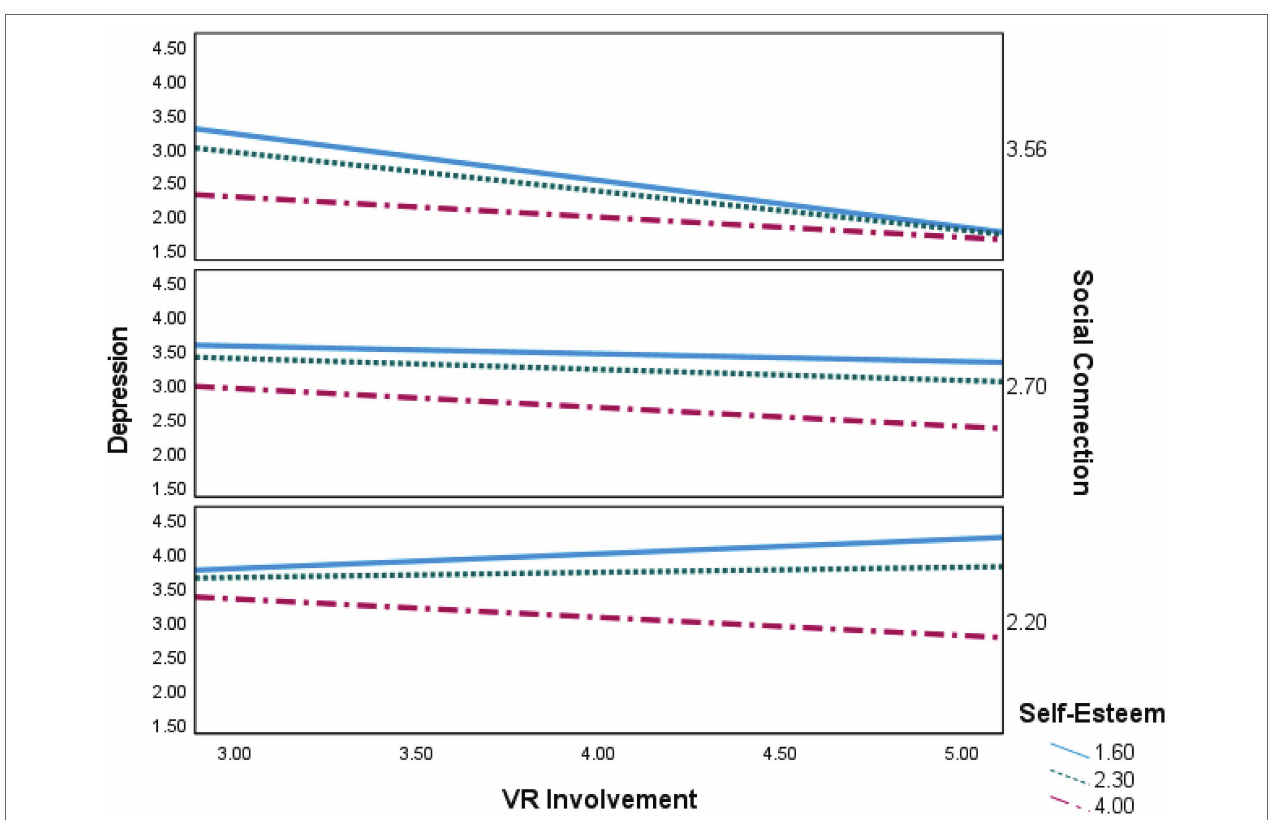
FIGURE 2 | The three-way interaction effect. Solid line represents low self-esteem level at 16th percentile; Dotted line represents medium self-esteem level at 50th percentile; and dash-dotted line represents high self-esteem level at 84th